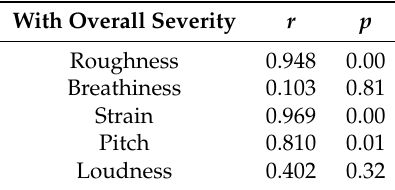
Figure 5. Cross-session variations mean and standard deviation values of CAPE-V ratings for all participants (n = 10). Table 4. Pearson correlation coefficients between the overall severity and other dimensions.